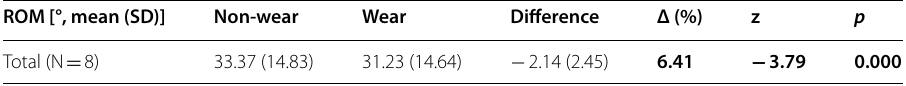
Items in bold: significant